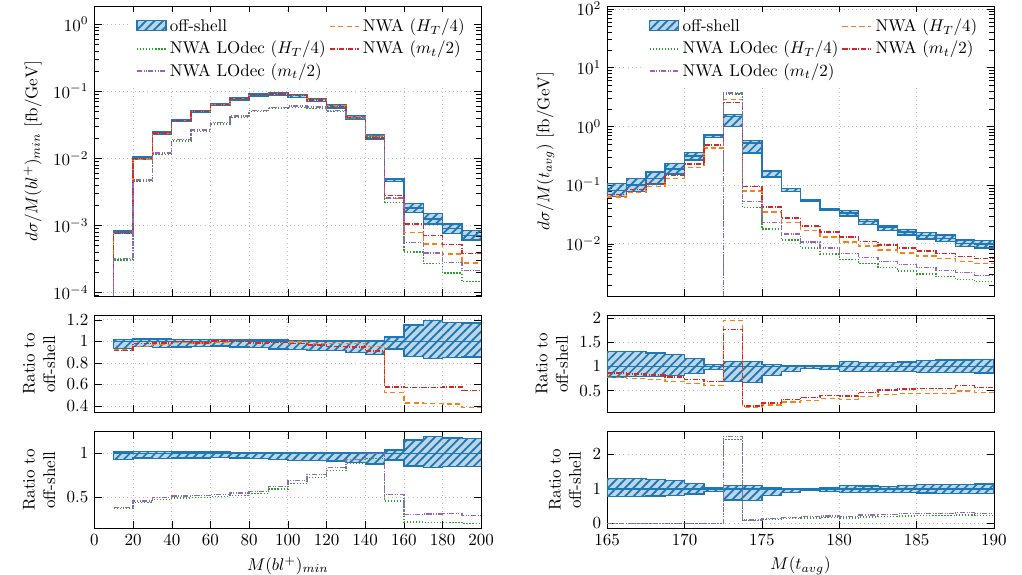
Figure 4 . Di(cid:11)erential cross section distribution as a function of the minimum invariant mass of the positron and bottom-jet, M ( be + ) min , and the (averaged) invariant mass of the top quark, M ( t avg ), for the pp e + (cid:23) e (cid:22) (cid:0) (cid:22) (cid:23) (cid:22) b (cid:22) b(cid:13) process at the LHC run II with p s = 13 TeV. The CT14 PDF set is !